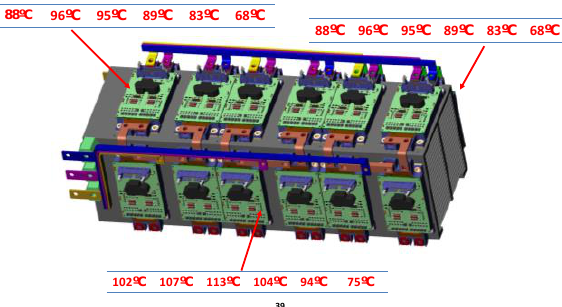
Figure 13. Temperature rise on negative temperature coefficient (NTC) sensors of IGBT modules ( V dc = ±400 V, I ac = 100 A).